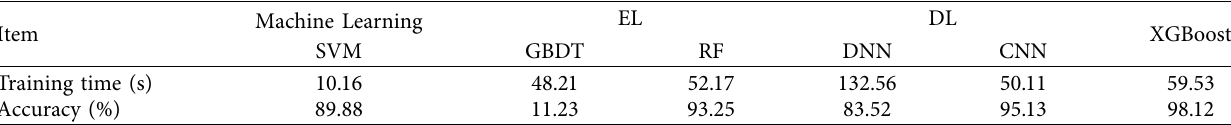
Figure 21: Data processing with EMD. Table 5: Comparison of different models for fault